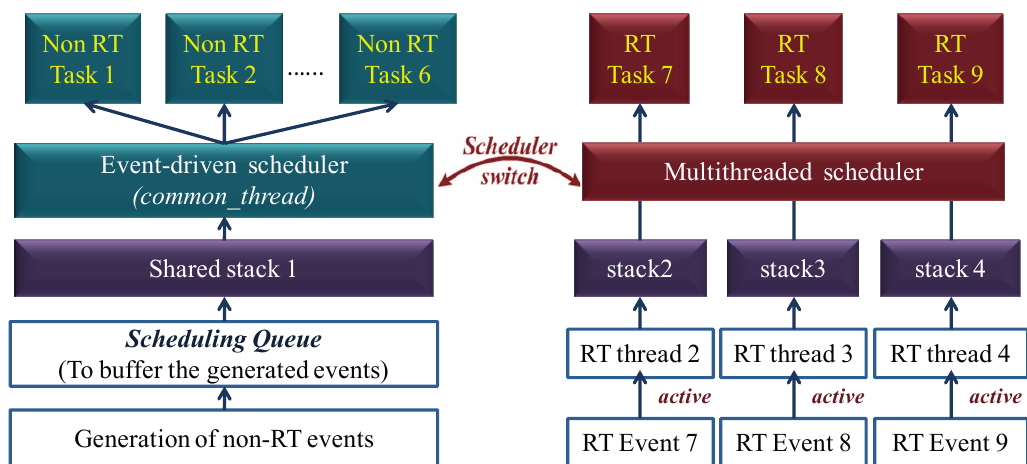
Figure 1. Hybrid scheduling structure in the